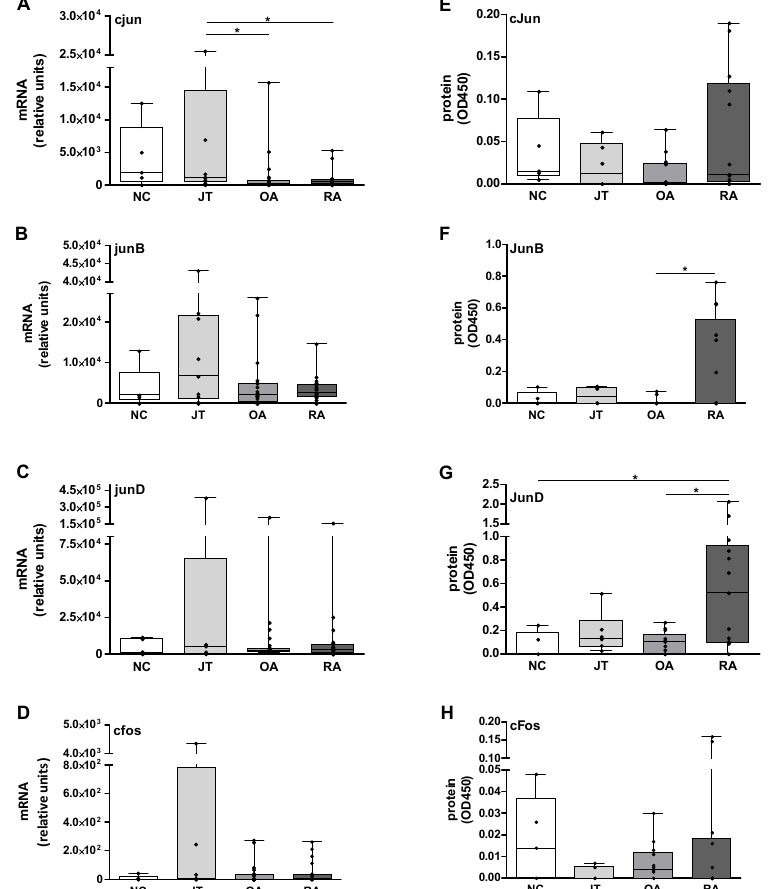
Figure 1. Quantitation of Jun / Fos mRNA and protein expression in the synovial membrane (SM). ( A – D ) The graph shows the median relative units (as detected by pPCR) for ( A ) cjun , ( B ) junB , ( C ) junD , and ( D ) cfos in rheumatoid arthritis (RA)- and osteoarthritis (OA)-SM (n = 24 each), joint trauma (JT)-SM (n = 9), and postmortem normal controls (NC)-SM (n = 5). All SM samples were positive for mRNA expression except for 1 RA and 1 OA sample ( cjun ), 2 OA samples ( junB ), 2 RA samples ( junD ), and 2 RA and 2 OA samples ( cfos ). ( E – H ) The median optical density (OD) at 450 nm (as detected by ELISA-based methods) for ( E ) cJun, ( F ) JunB, ( G ) JunD, and ( H ) cFos in RA-SM, OA-SM (n = 13 each), JT-SM (n = 6), and postmortem NC-SM (n = 5) are given. In all groups, the samples were a subgroup of the individuals used for mRNA analysis. SM samples were positive for protein expression except for 3 RA, 6 OA, and 3 JT samples (cJun), 7 RA, 11 OA, 3 JT, and 3 NC samples (JunB), 1 RA, 3 OA, and 2 NC samples (JunD), as well as 8 RA, 4 OA, and 4 JT, and 2 NC samples (cFos). Box plots are shown with horizontal lines for the respective median, boxes represent the 25th–75th percentiles, and whiskers indicate the extremes (min to max). Statistical analyses: Mann–Whitney U-test, * p ≤ 0.05. (conc.: